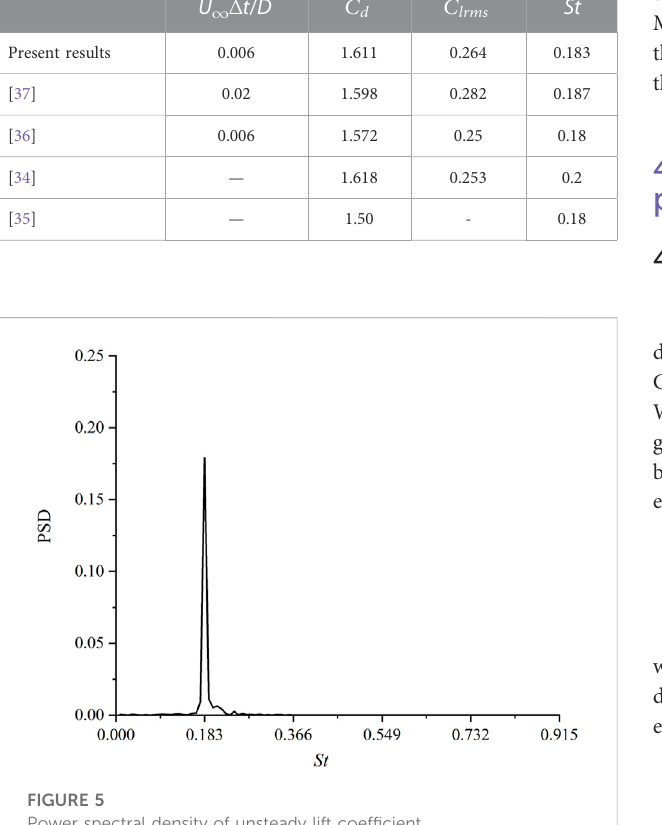
(RMS) values from different sources, where θ (cid:2) 0 and θ (cid:2) 180 + represent the stagnation point and rear point of the cylinder wall, respectively.